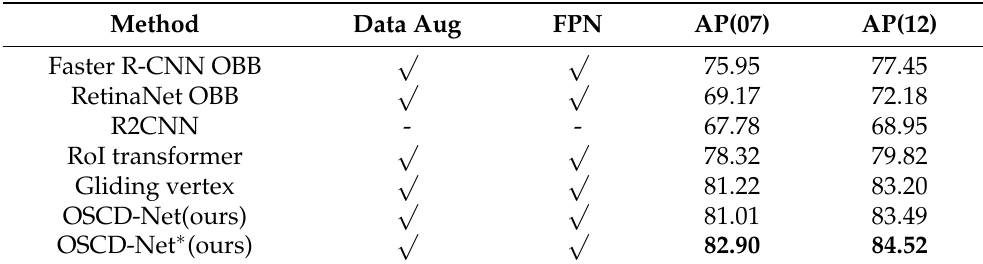
Table 7. Performance evaluation of nine different methods on the SSDD+ dataset. The highest value is indicated by bold numbers (%).